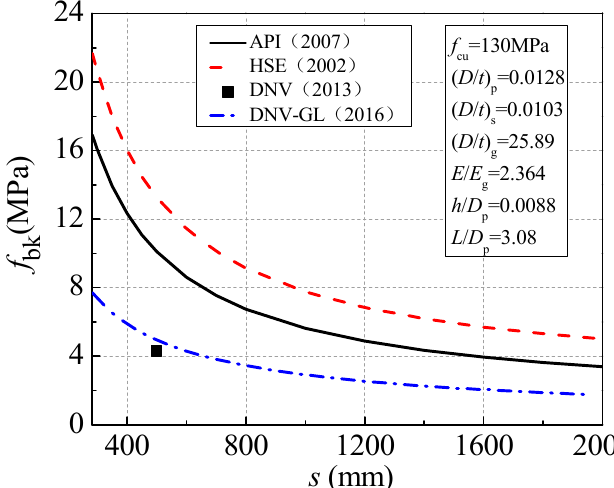
Figure 2. Relationship between interface shear strength ( f bk ) and shear key distance ( s ).